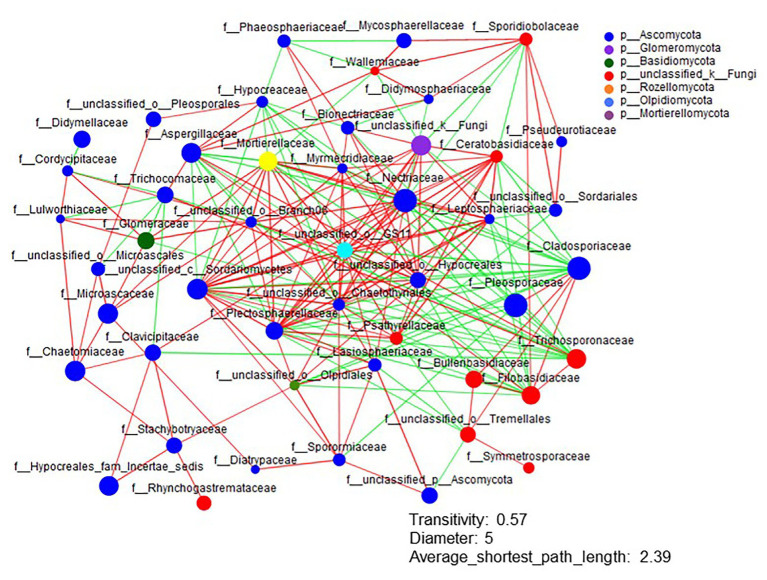
The network analysis of the fungal interactions from non-saline soils to extreme salinity soils. Colors of nodes represent different major phyla, and the node representing the family is shown inside. A red line indicates a positive interaction (coefficient was >0.5 and p was <0.01), whereas a green line indicates a negative interaction (coefficient was <−0.5 and p was <0.01) between two individual nodes.